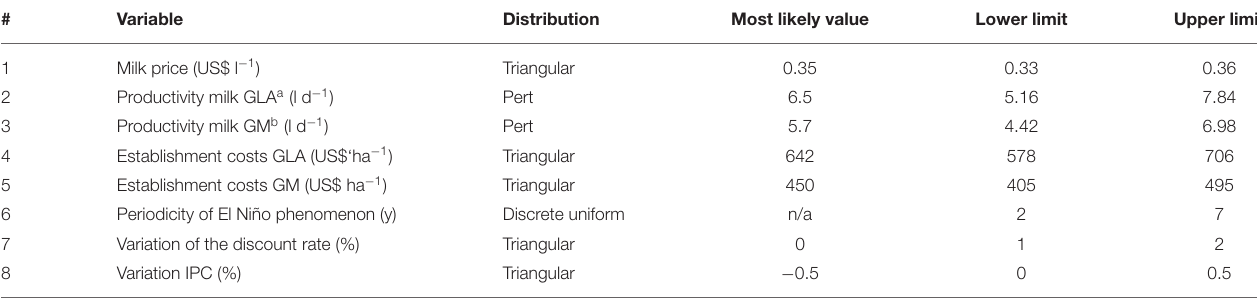
TABLE 2 | Variables simulated with the Monte Carlo model.